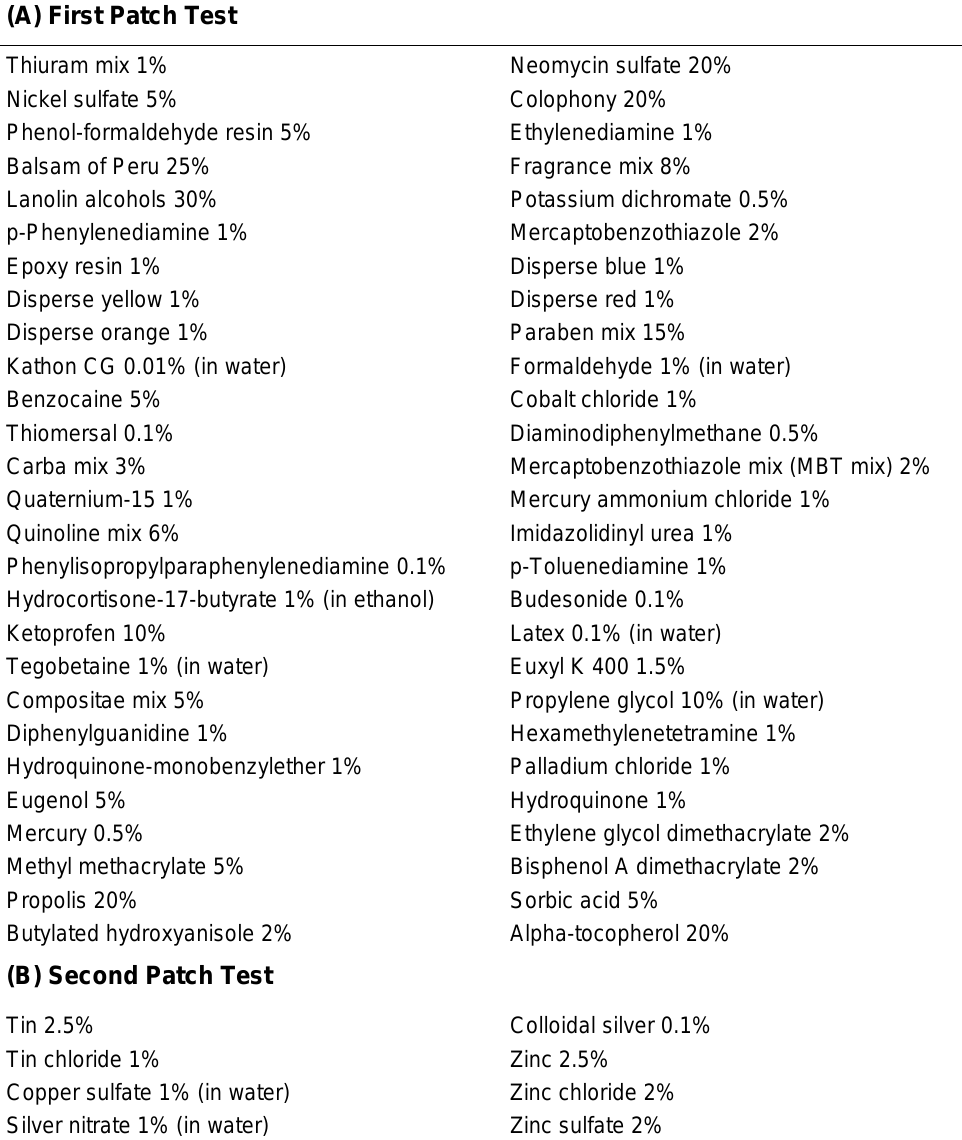
Haptens Used for First (A) and Second (B) Patch Test in our